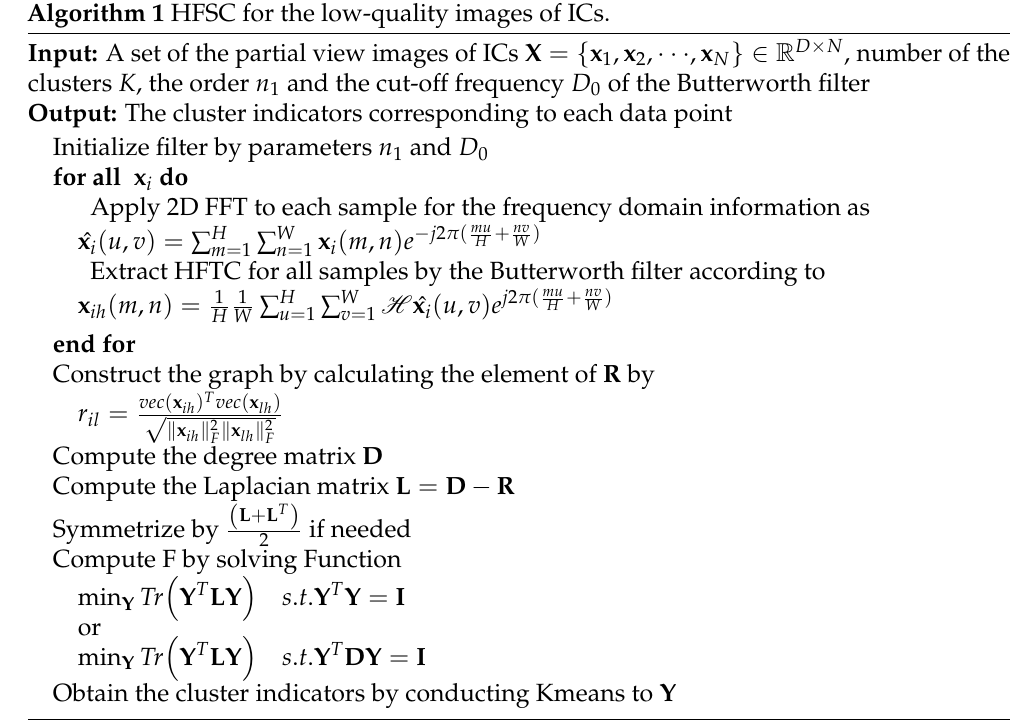
Algorithm 1 HFSC for the low-quality images of